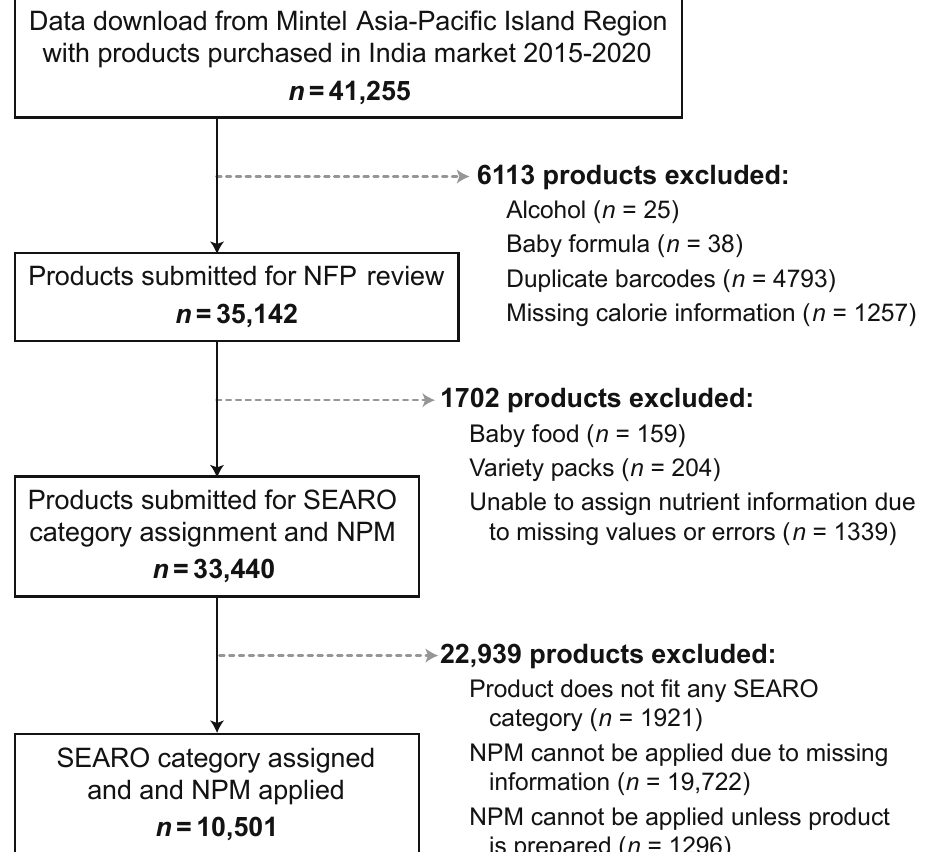
Figure 2. Flow diagram representing the initial and final dataset and reasons for exclusion. Note: NFP = nutrition facts panel; SEARO = South-East Asia Region Organization; NPM = nutrient profile model.